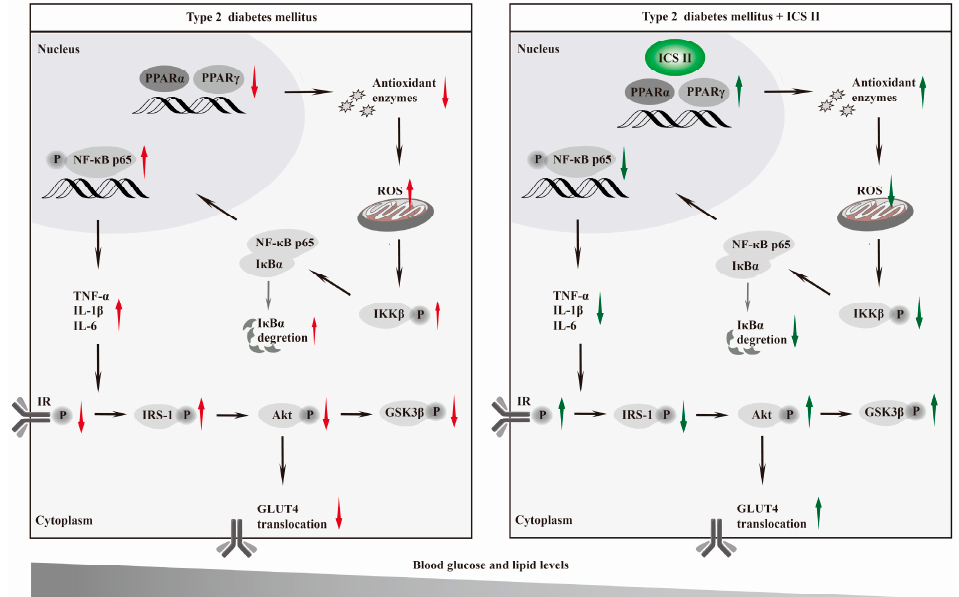
Figure 11. Graphic abstract Schematic depicting the role of ICS II on T2DM. ICS II attenuated hyperglycemia and hyperlipidemia by targeting PPAR α / γ : involvement of ROS/NF- κ B/IRS1 signaling pathway, leading to reduced levels of inflammatory factors and oxidative stress, as well as alleviation of insulin resistance.